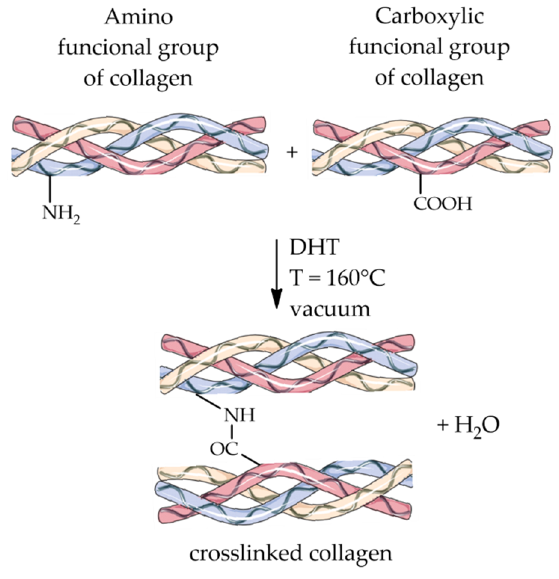
Figure 3. Schematic representation of the crosslinking reaction through dehydrothermal treatment.